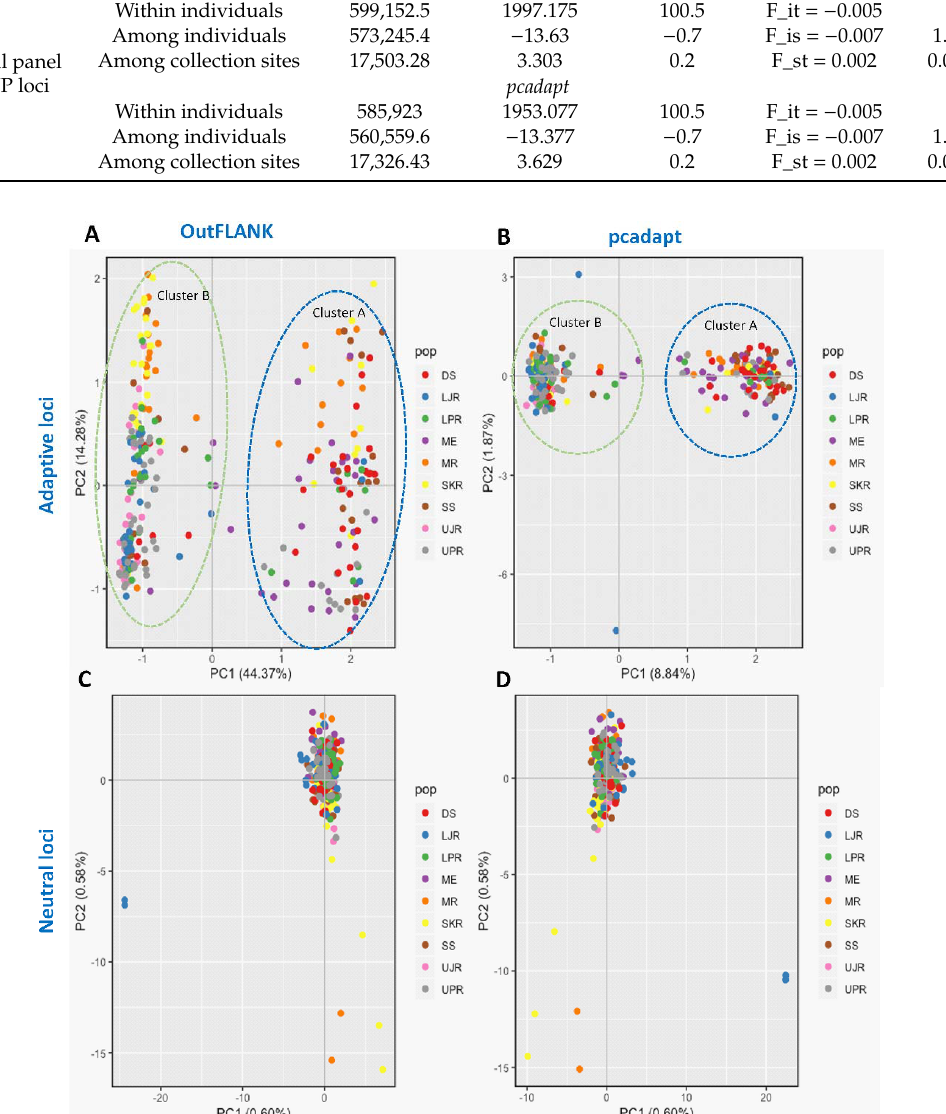
Figure 4. Scatterplots showing the principal components analysis (PCA) for: ( A,B ) The putatively adaptive panels of SNPs in the F ST OutFLANK ( A ) and pcadapt approaches ( B ); and ( C,D ) the putatively neutral panel of SNP loci in the F ST OutFLANK ( C ) and pcadapt approaches ( D ). DS, deep sea;